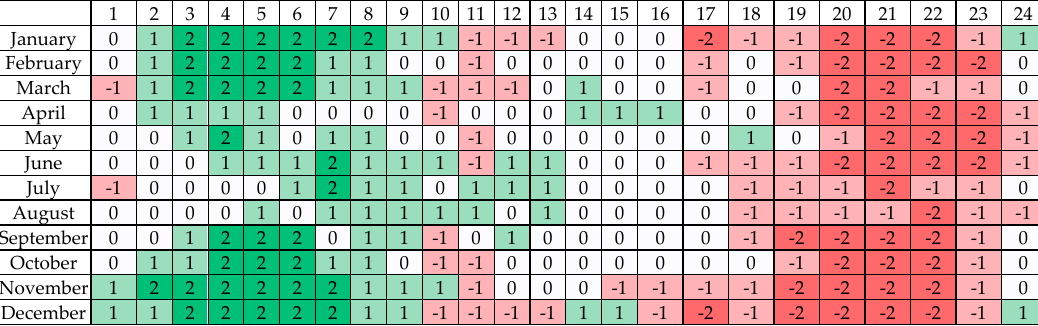
Figure 18. Strategy to optimise the load shifting: non-working days. ( − 2, Green) Strong Load reduction; ( − 1, Light Green) Weak Load reduction; (0, White) No Load variation; (1, Light Red) Weak Load increase; (2, Red) Strong Load increase.